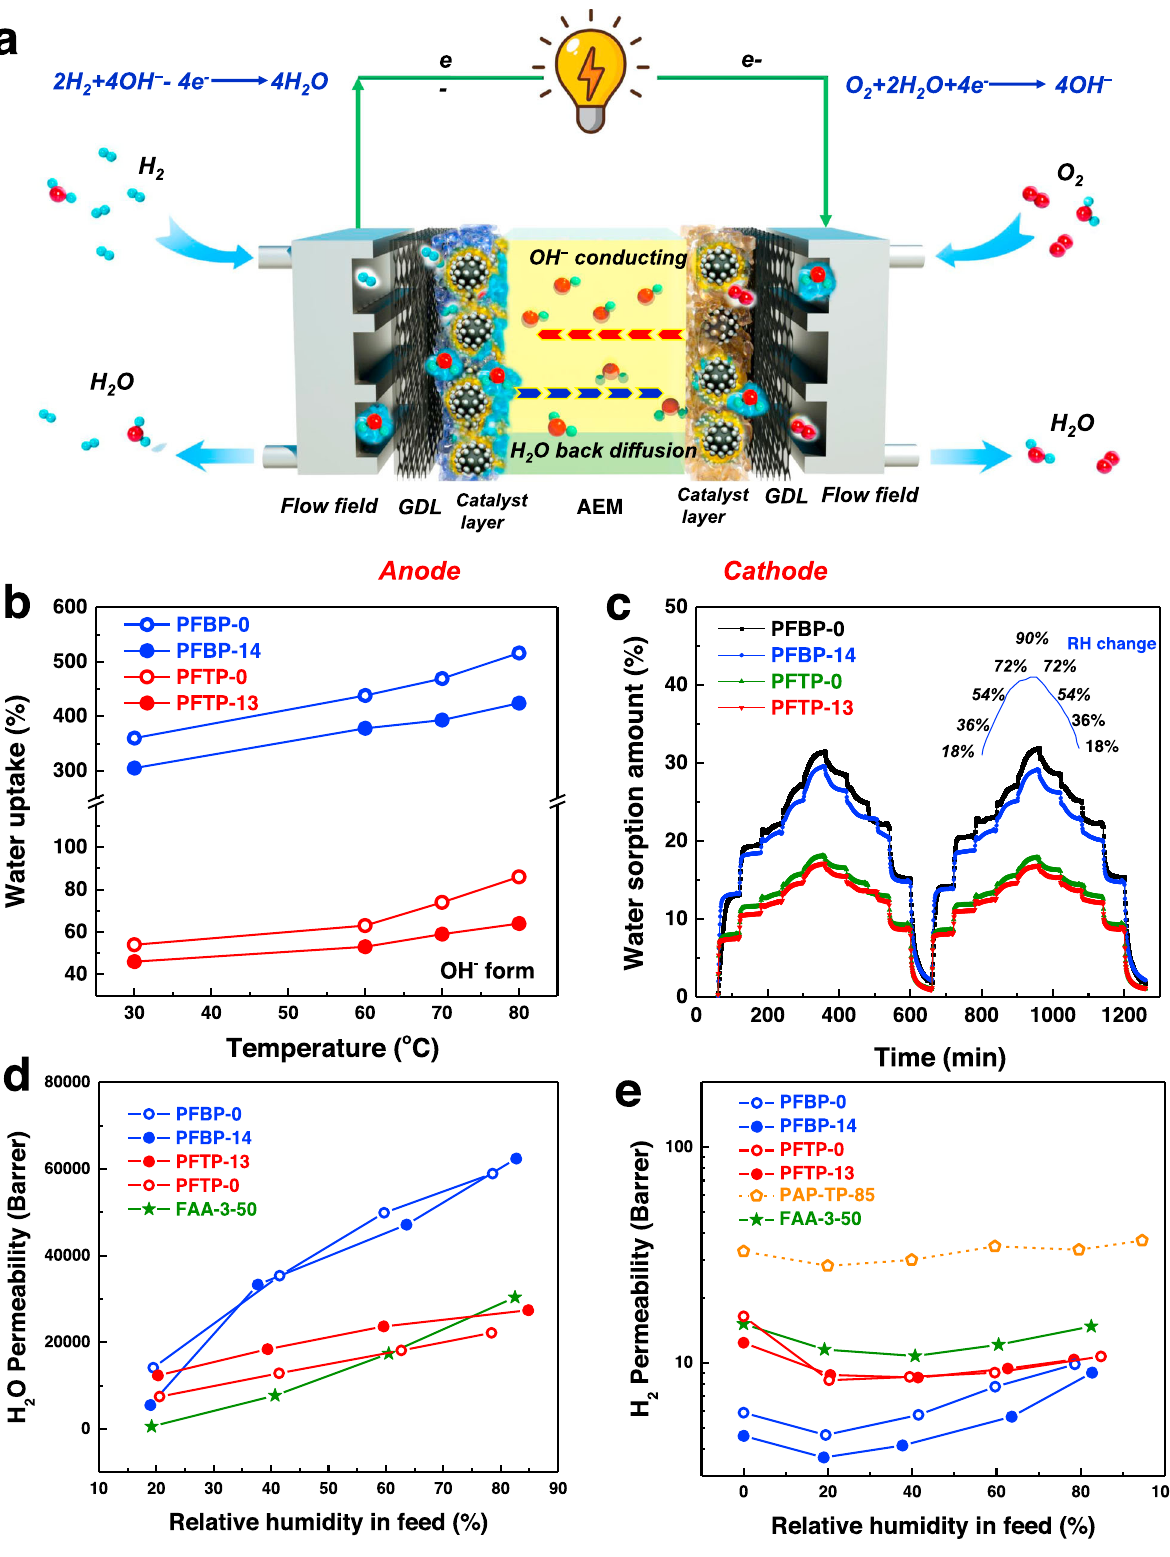
Fig. 2 Gas and water sorption and transport behavior. a Schematic diagram of the membrane electrode assembly (MEA) in AEMFCs emphasizing fuel gas and water transport. b The WU of PFBP-0, PFBP-14, PFTP-0, and PFTP-13 membranes in OH − form in liquid water. c Dynamic water vapor sorption behavior of PFBP-0, PFBP-14, PFTP-0, and PFTP-13 membranes at different RHs measured in a DVS instrument (RH changes between 18%, 36%, 54%, 72%, 90% at a time interval of 60 min) at 25 °C. RH is controlled to automatically increase in a DVS instrument at a given time interval. Two hydration – dehydration cycles were recorded. d Water vapor permeability, and e H 2 permeability of different AEPs in I − form at 60 °C under 2.2 bar unilateral backpressure. H 2 permeability of reported PAP-TP-x 17 is presented for